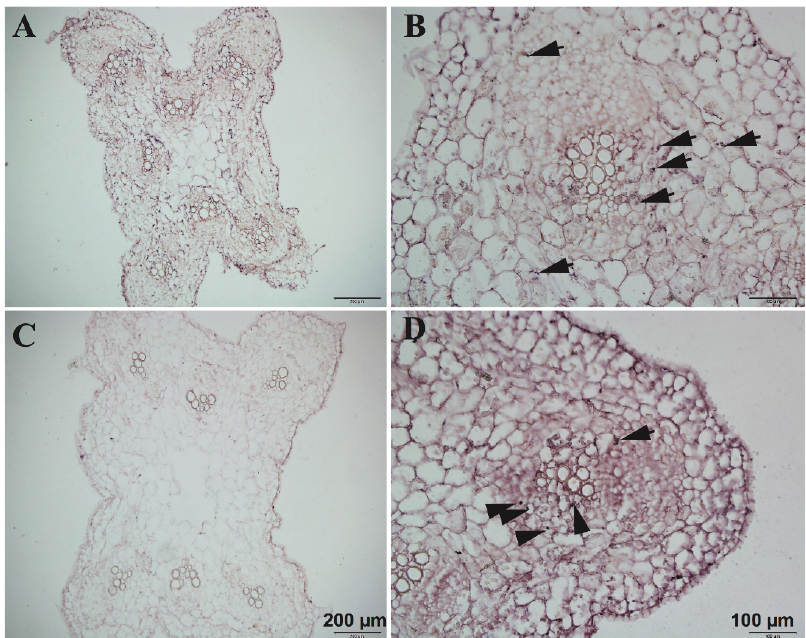
Figure 8. RNA in situ hybridization of cucumber CsNPF7.2 in cucumber root and hypocotyl. Cross-section of hypocotyl ( A , B ), root ( D ) and sense probe controls of hypocotyls ( C ) of 15-day-old cucumber seedling. Red scales bars in all images are 100 µ m and 200 µ m. RNA signals are indicated by black arrowhead.